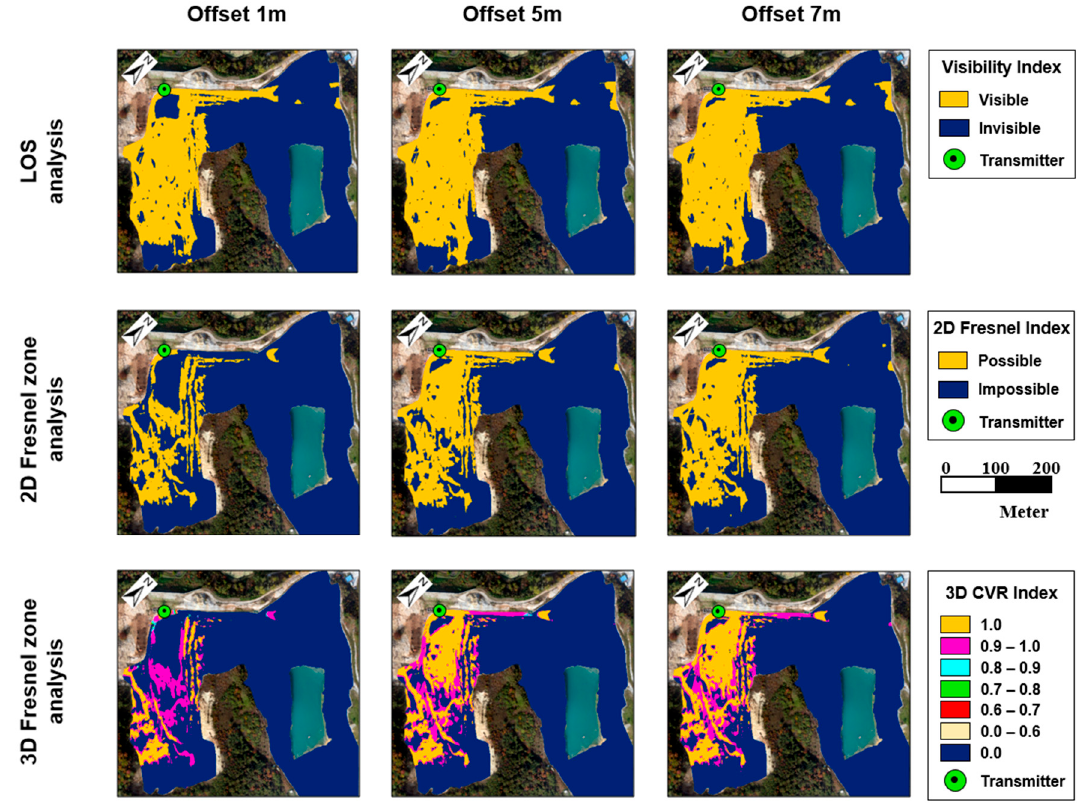
Figure 9. Index maps produced by each method for transmitter 1 for a frequency threshold of 900 MHz and transmitter offset heights of 1 m, 5 m, and 7 m. Table 2. Variation of index values and the coverage ratio derived from each method for offset height thresholds of 1 m, 3 m, 5 m, and 7